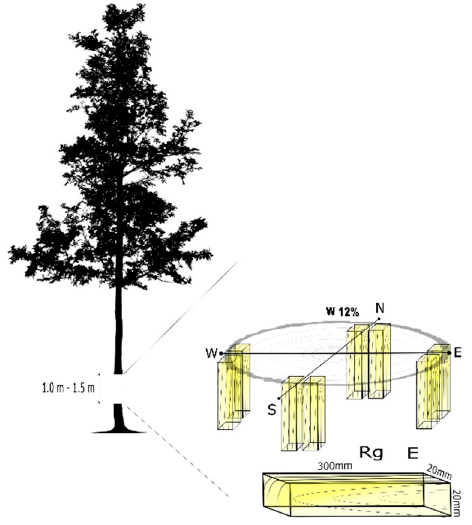
Figure 2. The method of collecting samples for the study.